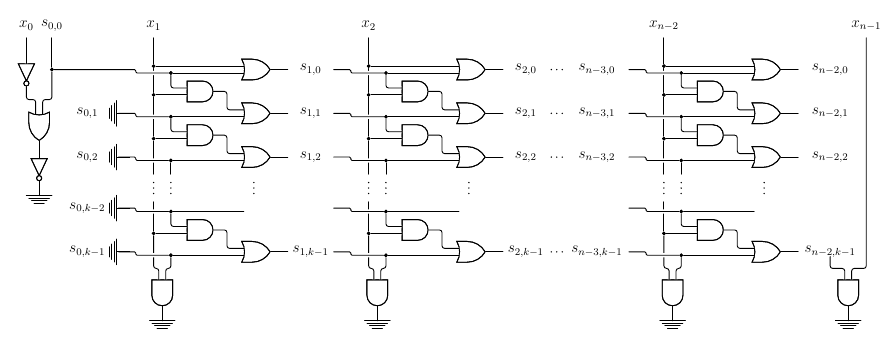
Figure 3: Sequential counter